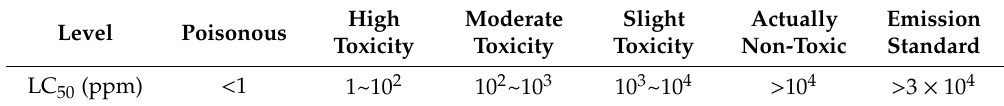
Table 11. Biological toxicity level classification